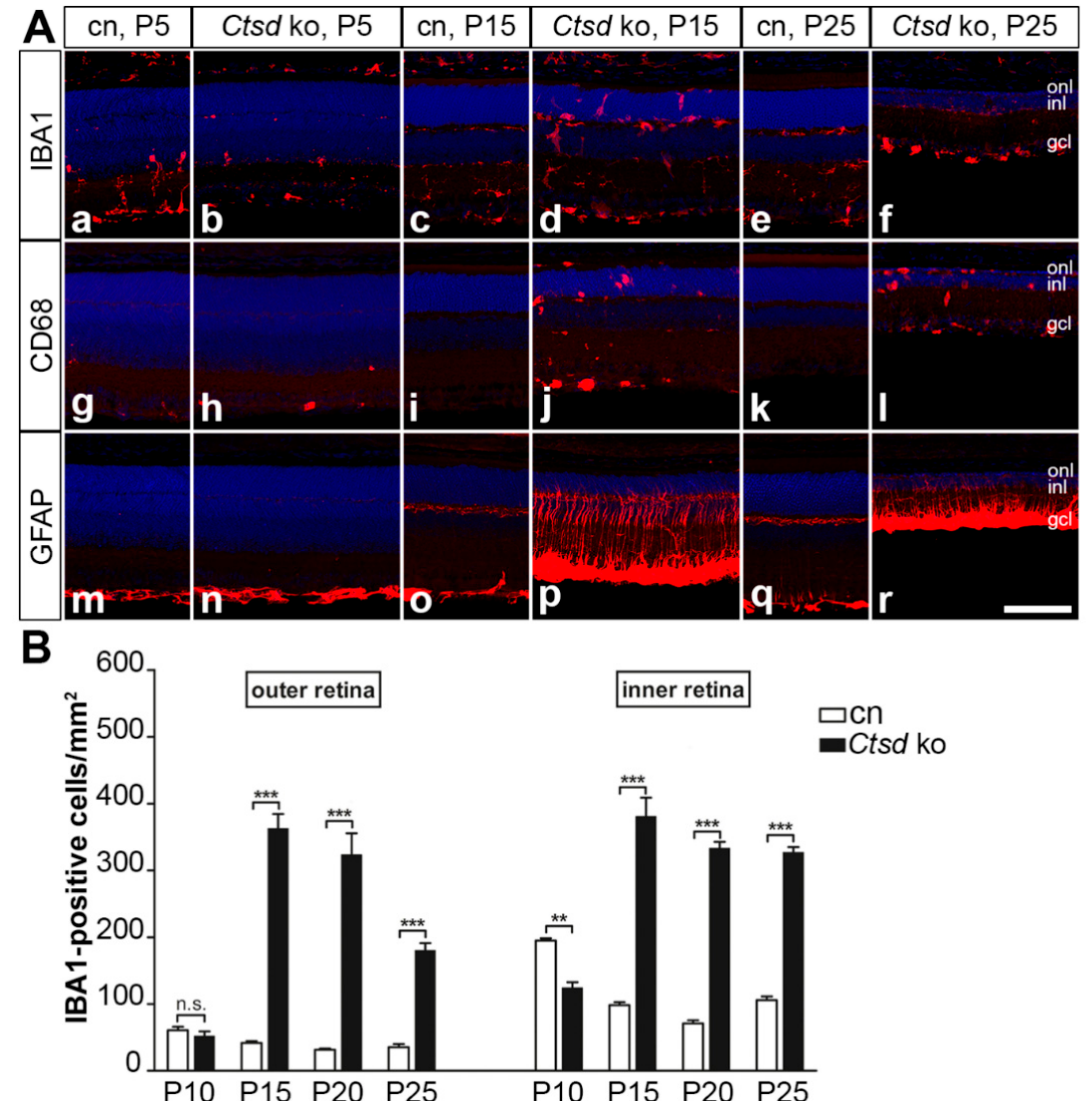
Figure 2. Reactive microgliosis and astrogliosis in Ctsd ko retinas. ( A ) At P5, IBA1-positive microglia cells were more numerous in control retinas ( Aa ) than in mutant retinas ( Ab ), while at P15 and P25, the density of IBA1-positive cells was markedly increased in mutant retinas ( Ad and Af , respectively) when compared with age-matched control retinas ( Ac , Ae , respectively). CD68-positive cells were confined to the inner retina of mutant mice at P5 ( Ah ), and increased in number and became additionally detectable in the outer nuclear layer and subretinal space of P15 ( Aj ) and P25 ( Al ). Control retinas were almost devoid of CD68-positive cells at all ages analysed ( Ag , Ai , Ak ). Expression of GFAP in control ( Am , Ao , Aq ) and P5 mutant retinas ( An ) was confined to retinal astrocytes. In P15 ( Ap ) and P25 ( Ar ) Ctsd ko retinas, expression levels of GFAP were markedly elevated in retinal astrocytes, and Müller cells were strongly GFAP-immunoreactive. ( B ) The density of IBA1-positive cells in the outer and inner retina of control (open bars) and Ctsd ko mice (filled bars) at different ages. Each bar represents the mean value (±SEM) of 6 animals. n.s., not significant; **, p < 0.01; ***, p < 0.001, two-way ANOVA. CD68, cluster of differentiation 68; cn, control; gcl, ganglion cell layer; GFAP, glial fibrillary acidic protein; IBA1, ionized calcium-binding adapter molecule 1; inl, inner nuclear layer; ko, knock-out; onl, outer nuclear layer; P, postnatal day. Scale bar: 100 µm.